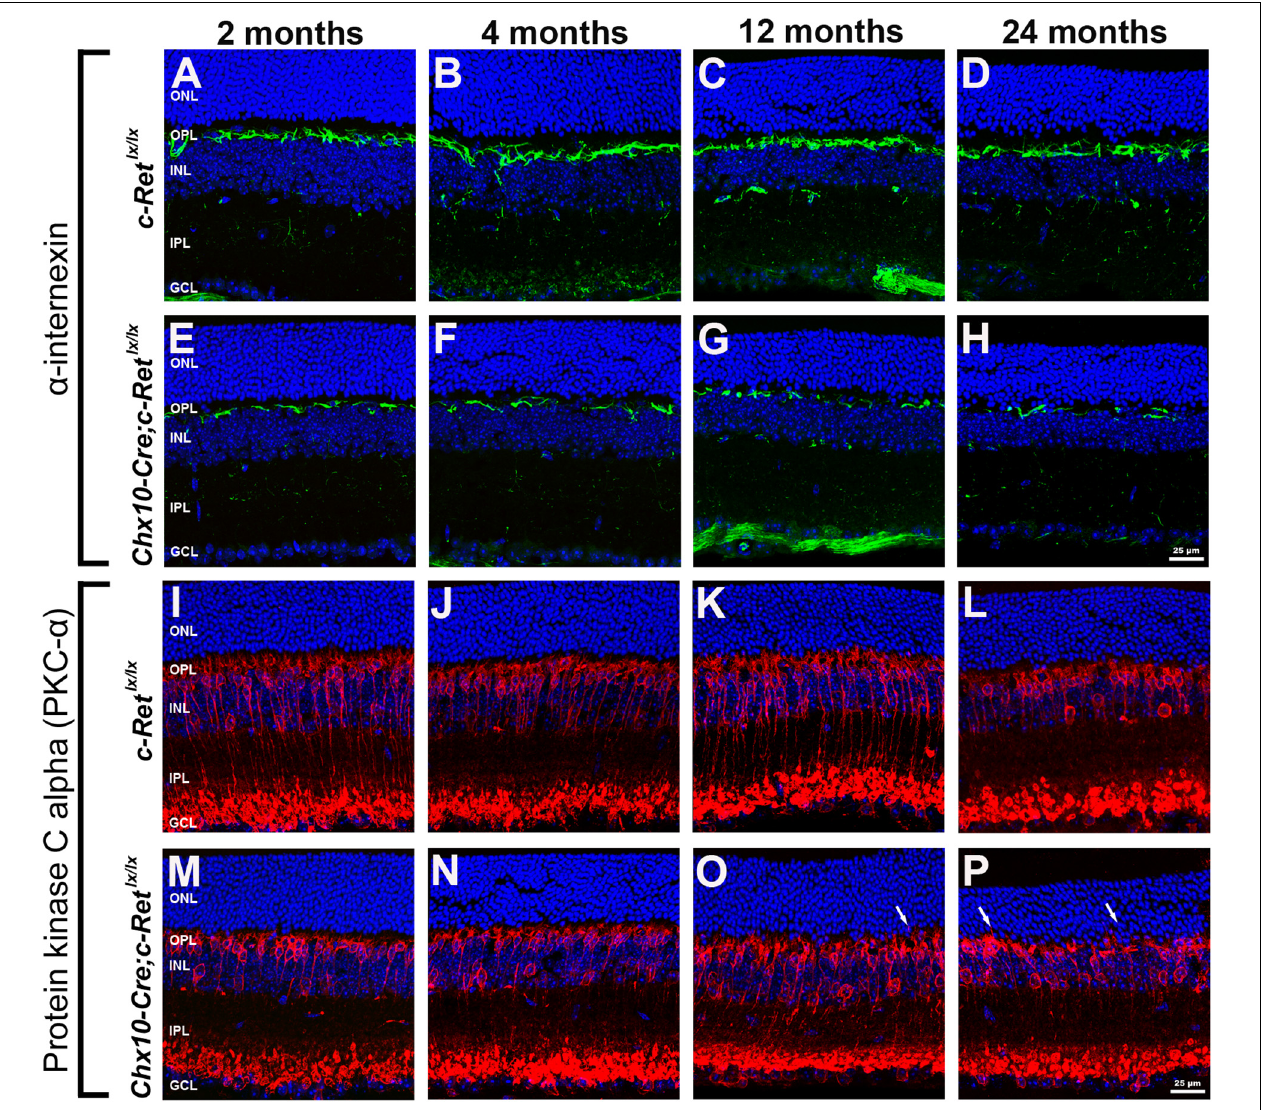
FIGURE 5 | Immunohistochemistry of horizontal cells and rod bipolar cells in C-Ret lx / lx and Chx10-Cre;C-Ret lx / lx retinas. Retinal sections of mice aged 2, 4, 12, and 24 months were immunostained with an anti- α -internexin antibody (green, A–H ) or an anti-PKC- α antibody (green, I–P ), to label horizontal cells and rod bipolar cells, respectively, followed by counterstaining with Hoechst dye, to reveal cell nuclei (blue). Compared with C-Ret lx / lx mice (A–D) , the processes of horizontal cells were sparse and discontinuous in Chx10-Cre;C-Ret lx / lx mice and were even more deteriorated at the ages of 12 and 24 months (E–H) . The processes of rod bipolar cells were similar between C-Ret lx / lx (I–L) and Chx10-Cre;C-Ret lx / lx (M–P) mice aged 2, 4, 12, and 24 months. However, some processes of rod bipolar cells extended into the ONL at the ages of 12 and 24 months in Chx10-Cre;C-Ret lx / lx mice ( O,P , arrows), which was not observed in C-Ret lx / lx mice. ONL, outer nuclear